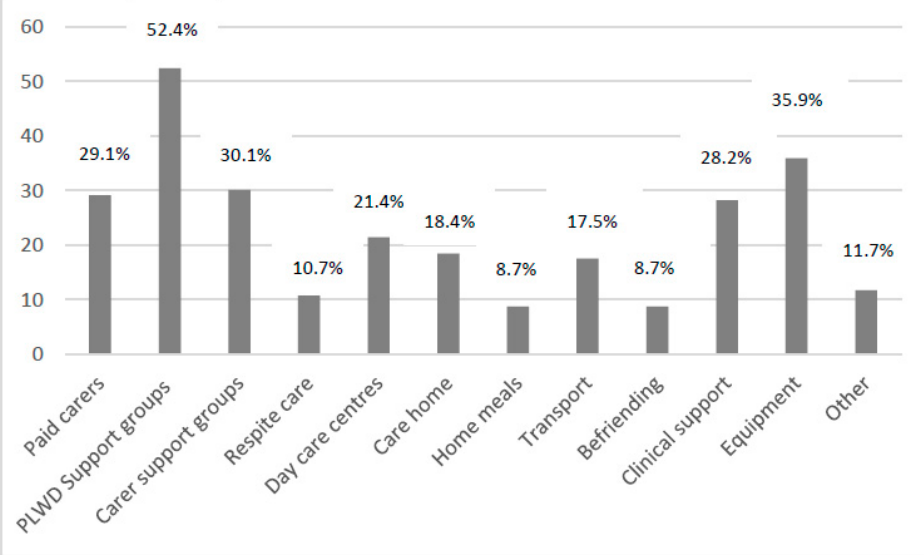
Figure 2. Social support service usage. Legend. PLWD = Person living with dementia.